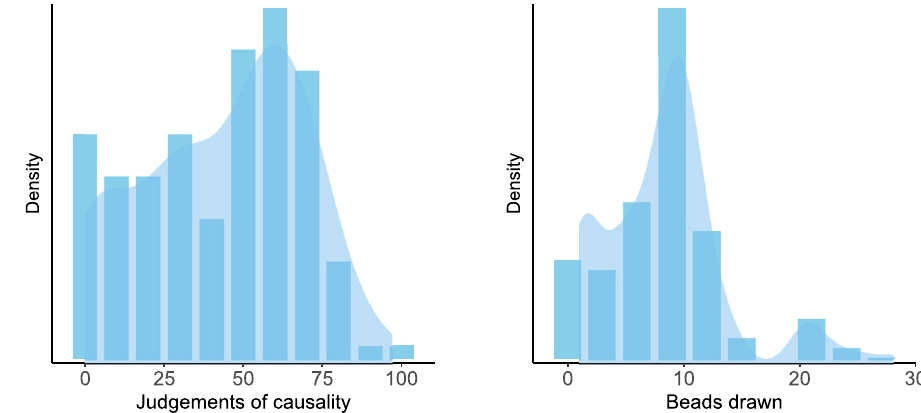
Figure 4. Histograms and density plots for the contingency learning task (left panel) and Beads task (right panel) in Study 1.